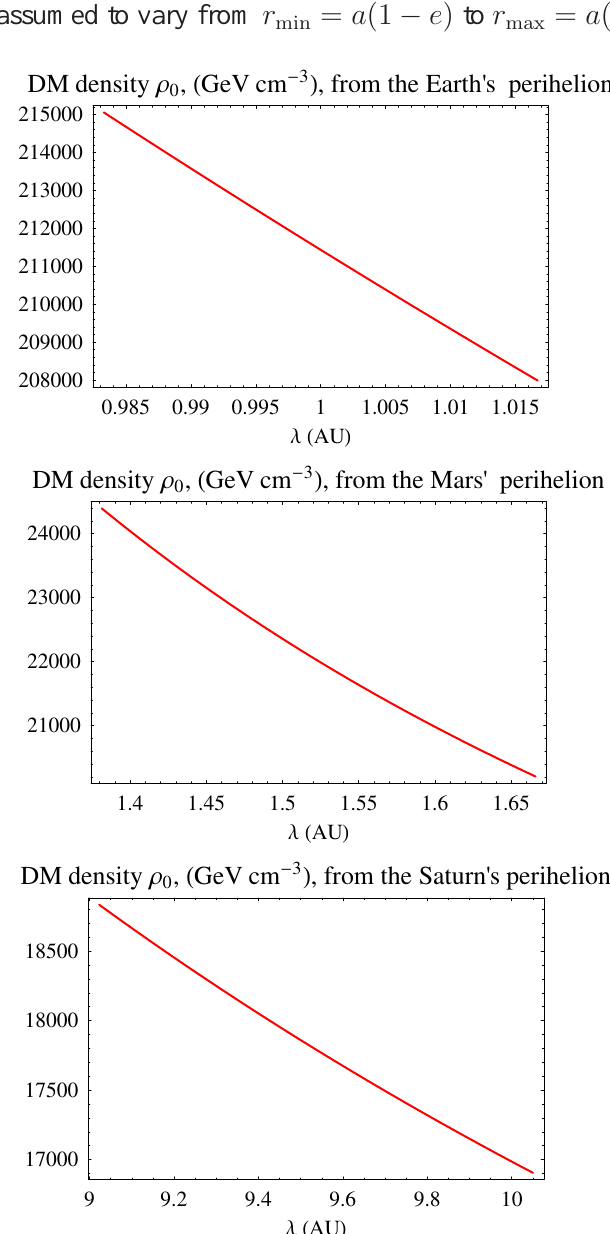
Figure 1. Upper bounds, in GeV cm − 3 (1 GeV cm − 3 is equivalent to 1 . 78 on the DM density parameter ρ 0 as a function of the characteristic scale length λ of Equation (5). The supplementary perihelion precessions of Table 1 for Earth, Mars